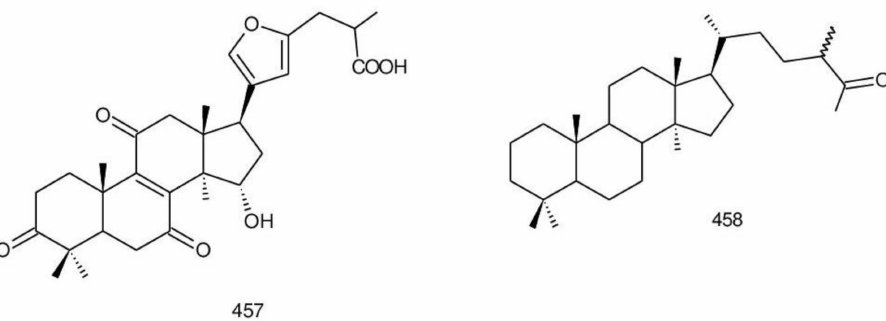
Figure 22. Chemical structures of furanoganoderic acid ( 457 ) and 24 ζ -methyl-5 α -lanosta-25-one ( 458 ) as rearranged novel